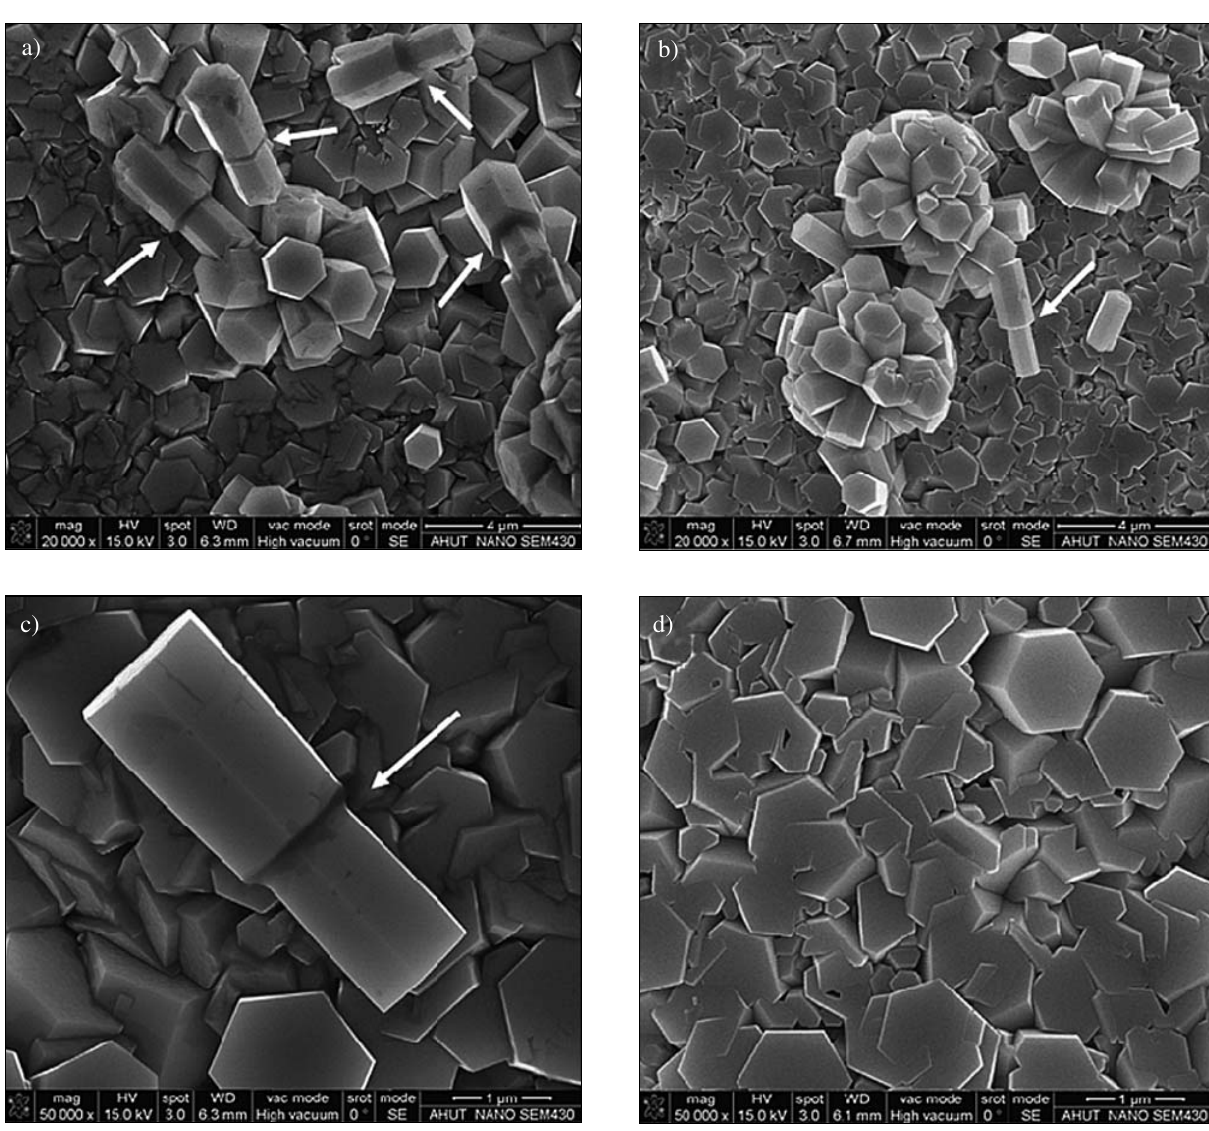
Fig. 4. SEM images of (a) ZnO microrods grown at 105°C and 60 min. (b) ZnO microrods grown at 105°C and 80 min. (c) The typical twinned ZnO structure, and (d) the dense ZnO microrod